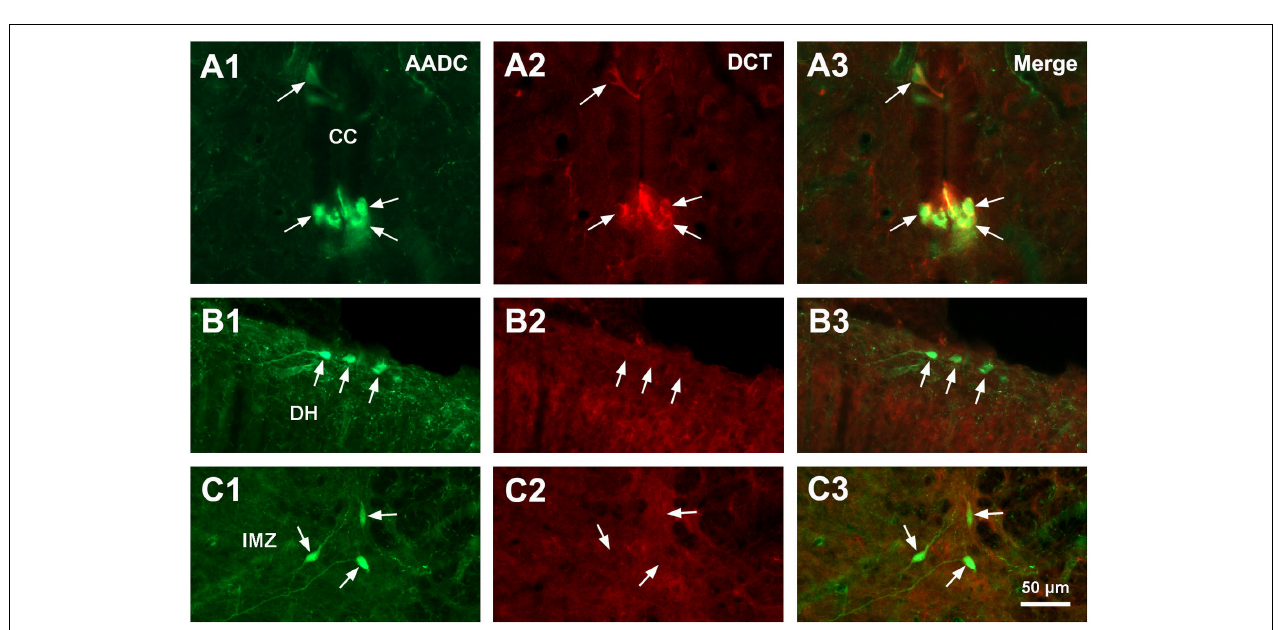
FIGURE 2 | Aromatic L -amino acid decarboxylase and NeuN double-immunostaining indicates that AADC cells in the spinal gray matter are neurons. (A1–C3) AADC neurons around the CC were weakly immunolabeled with NeuN (A1–A3) , whereas in the DH (B1–B3) and the IMZ (C1–C3) they were densely immunolabeled with NeuN (arrows). AADC antibody was from rabbit. Scale bar in (C3) , valid for all panels, 50 µ m.